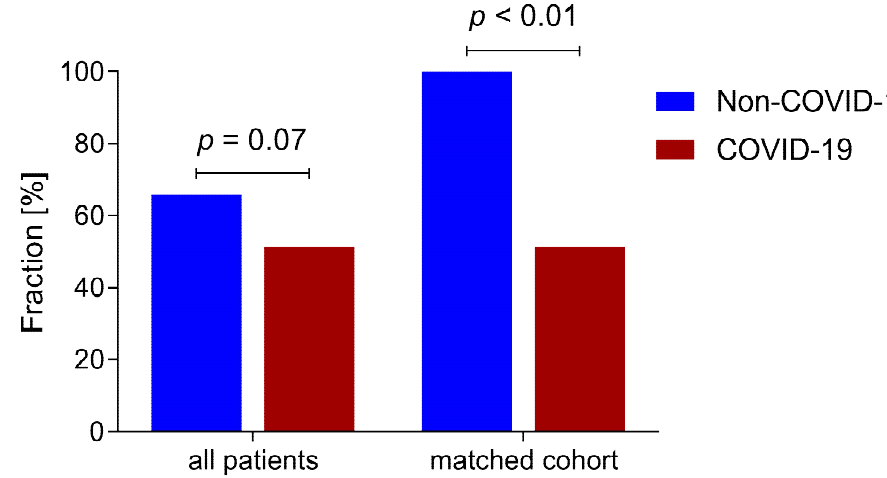
Figure 5. Delirium incidence. Graph shows delirium incidence in all patients and a propensity score matched cohort of COVID-19 and non-COVID-19